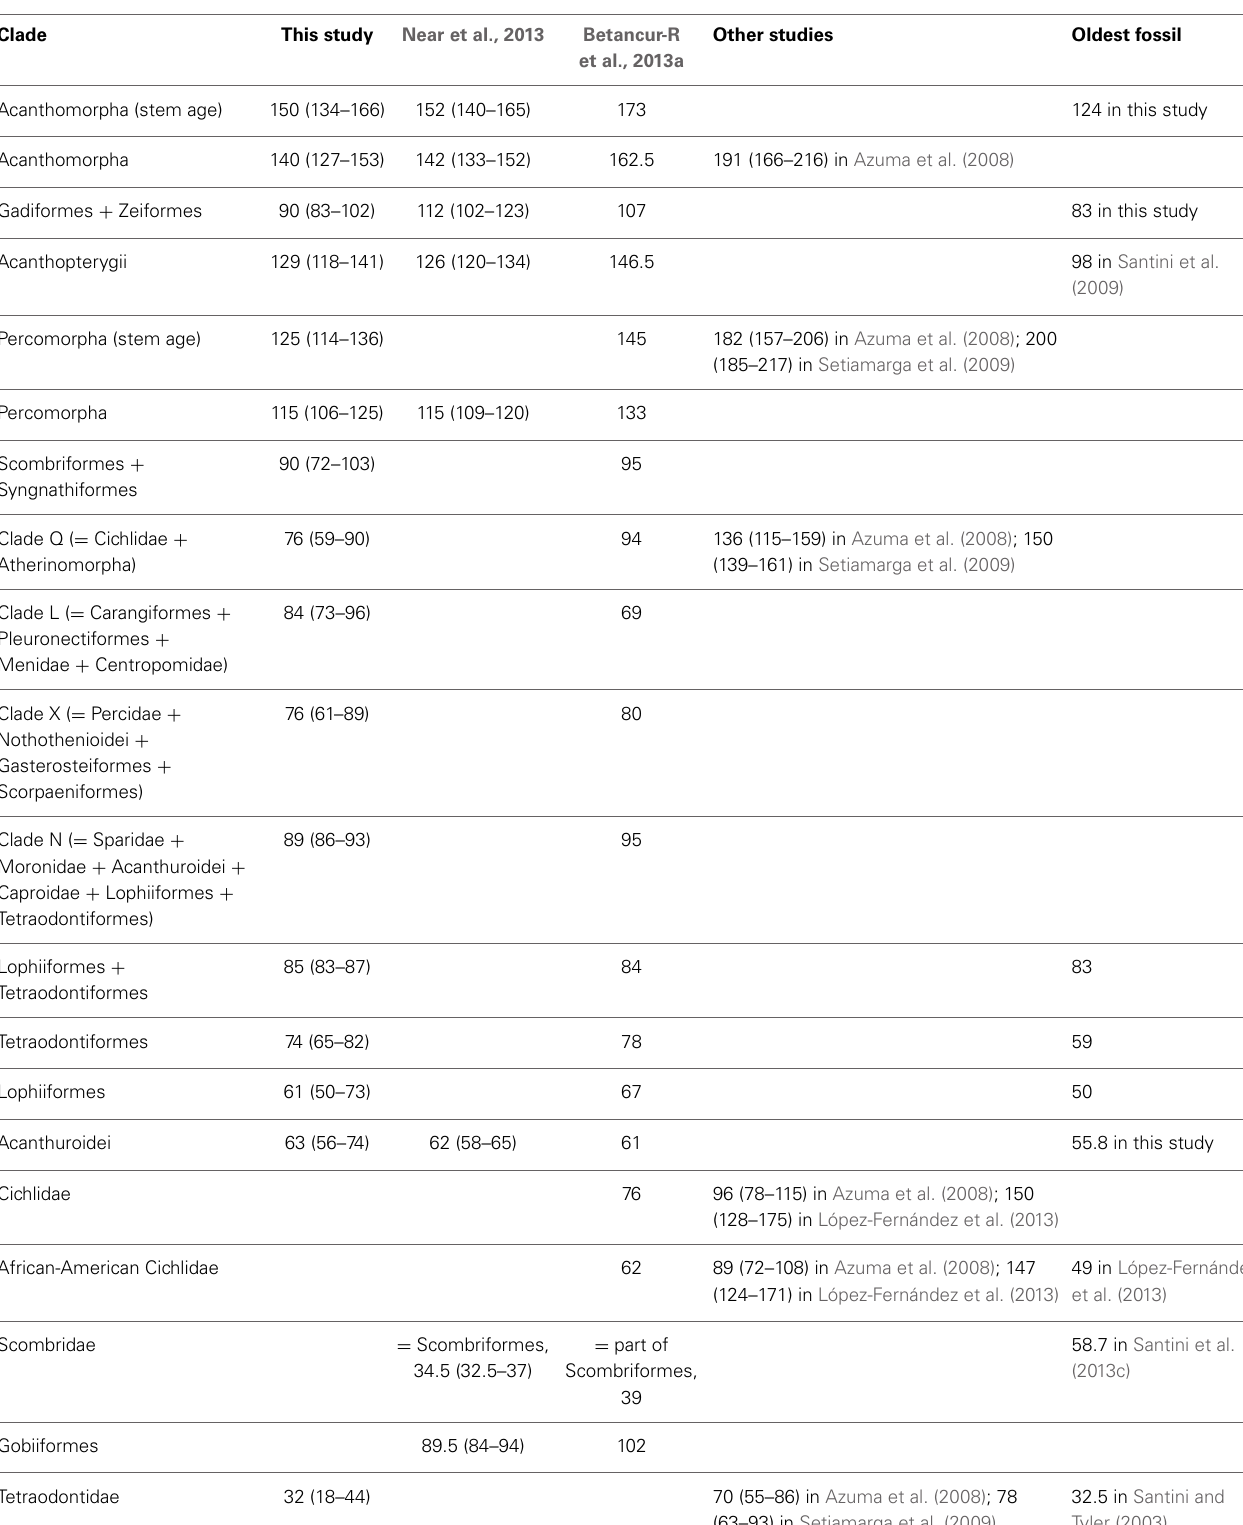
Table 1 | Ages (in million years ago) estimated by this study, by recent published molecular timetrees and by the oldest fossil for the Acanthomorpha and for its major